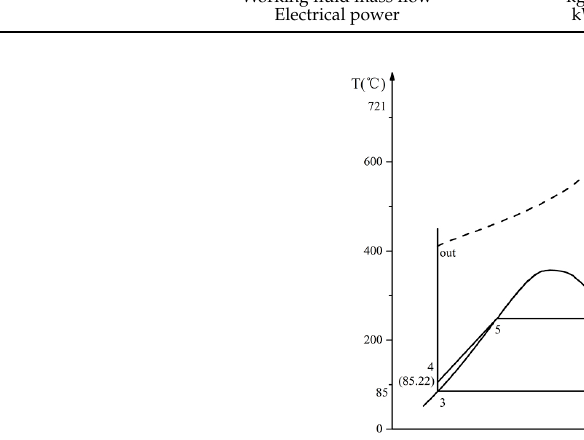
Table 4. Test results of the Rankine recovery system.